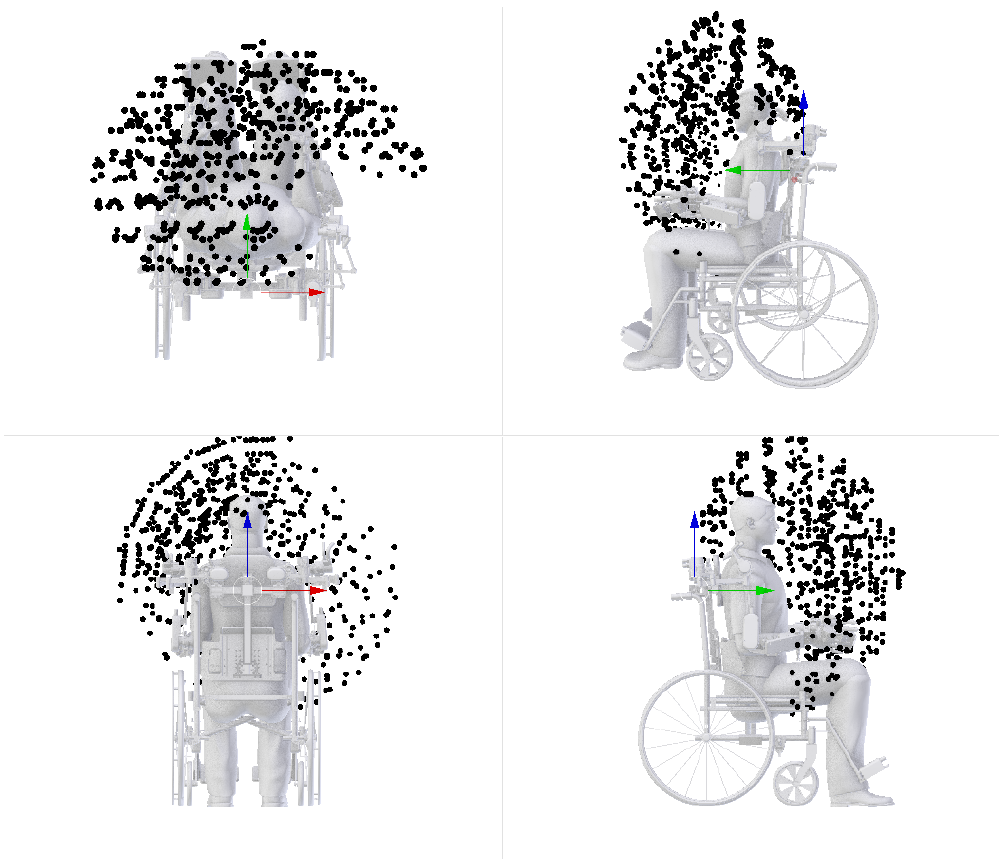
Figure 8. Workspace of the R ECUPERA single